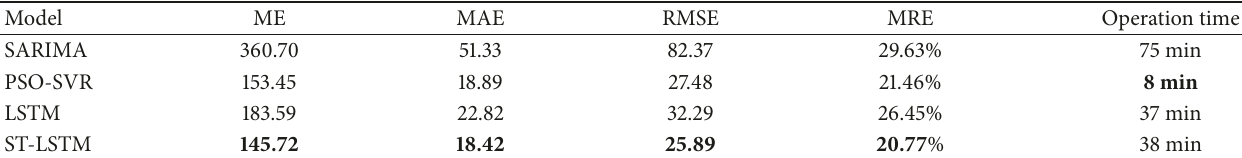
Table 1: Performance of four